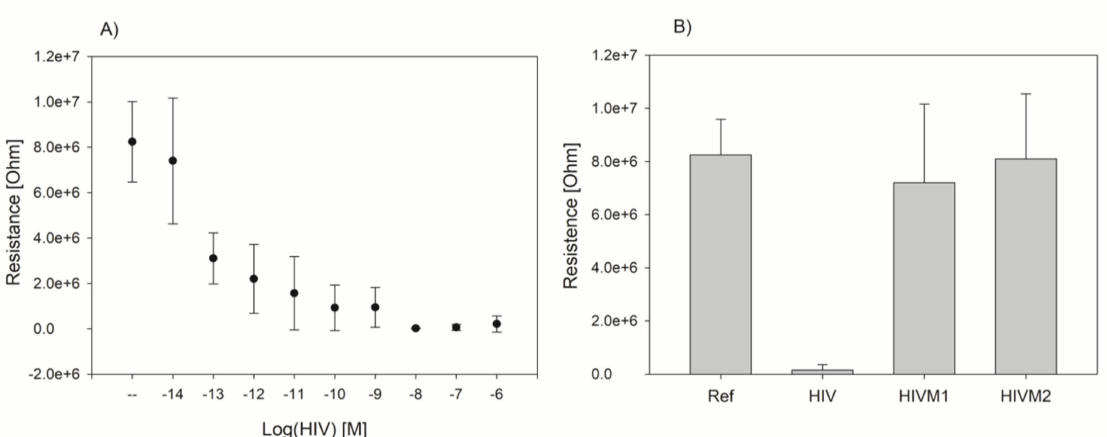
Figure 4. Concentration dependence of resistance measured on the electric chip for HIV DNA target sequence ( A ), selectivity of the method demonstrated on target DNA sequences with one (HIVM1) or two mismatches (HIVM2); samples were at 1 µ M concentration ( B